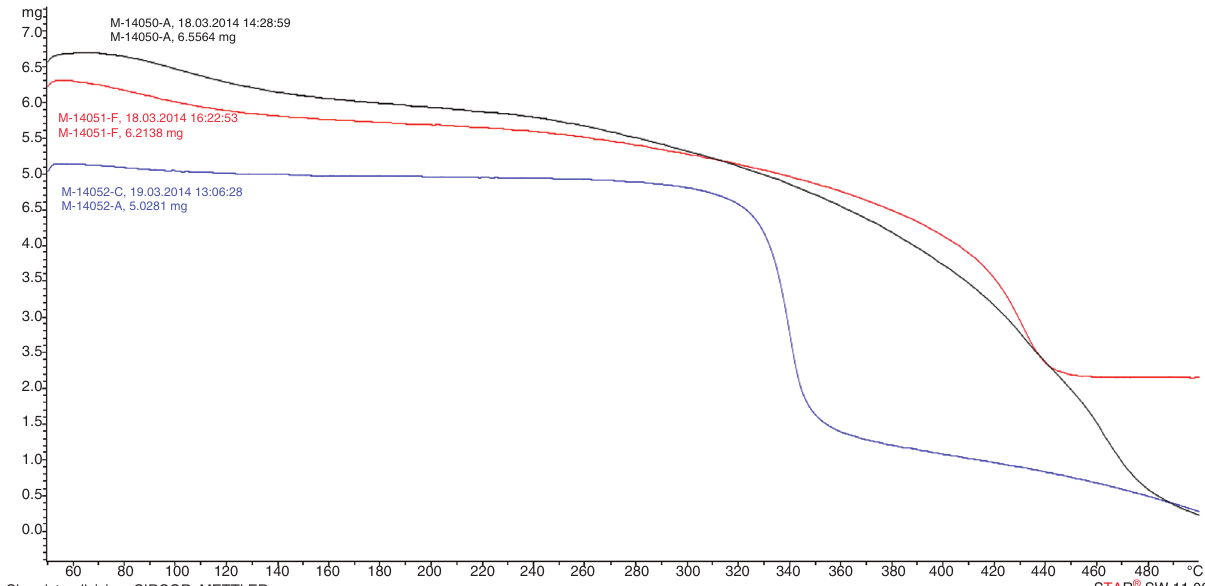
Figure 1 Comparison of different catalysts in terms of TGA. (A) Commercially available untreated cellulose, (B) catalyst obtained from hydrothermal carbonization followed by sulfonation of the commercially available cellulose, (C) catalyst obtained from hydrothermal car- bonization followed by sulfonation of the waste paper pretreated with ultrasonically assisted alkaline